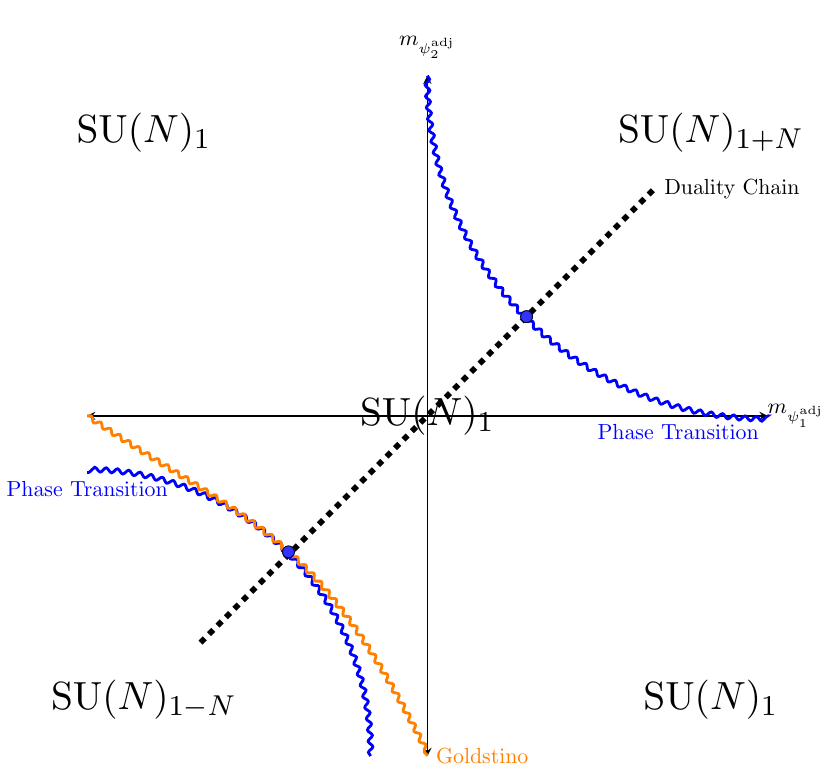
Figure 14 . Generic shape of the two dimensional phase diagram for SU( N ) 1 +2 adj . The diagonal black line represent the region where duality chain applies. Near the boundary j m j ! 1 , we could use the phase diagram of single adjoint fermion reviewed in the section 2 to infer the phase in the middle region. Our case is special since their is no quantum phase at the boundary, thus it is natural to predict that SU( N ) 1 phase in the 2nd and 4th quadrant are smoothly connected through the middle region.